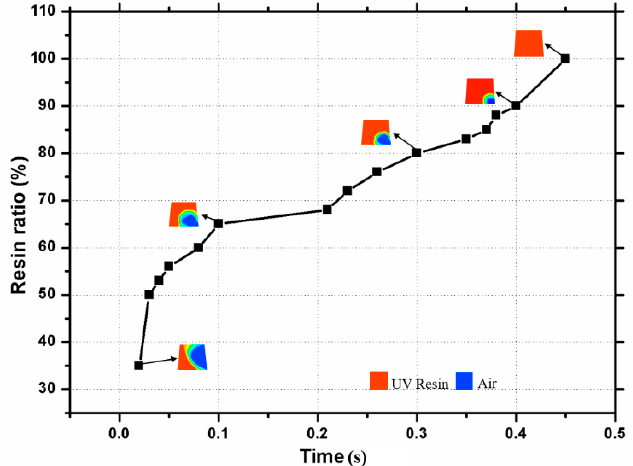
Figure 11. UV resin filling percentage into single microcavity at different times at a PET web speed of 24.2 mm/s.